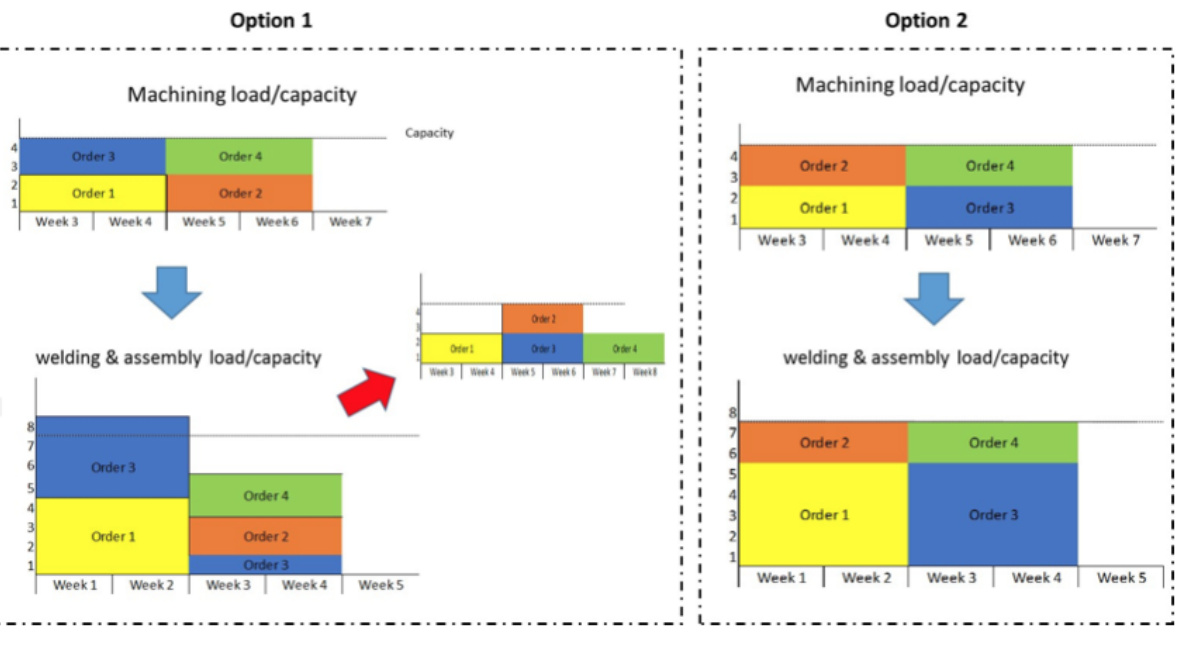
Figure 6. Illustrative example of the bottleneck exploitation based on the case study (real problem found during the action research